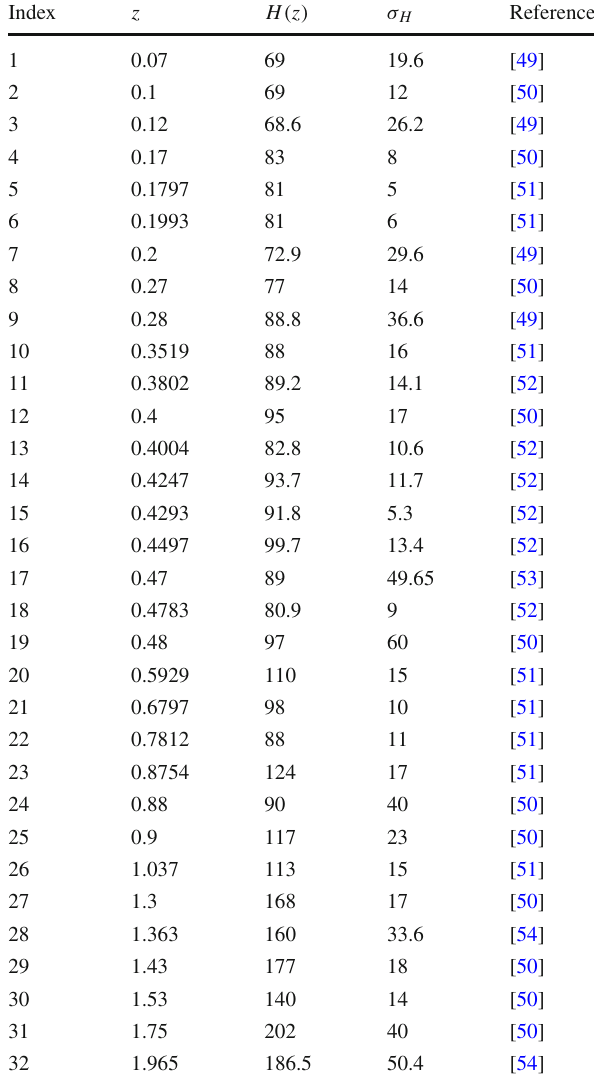
Table 1 The Cosmic Chronometer Hubble parameter H ( z )